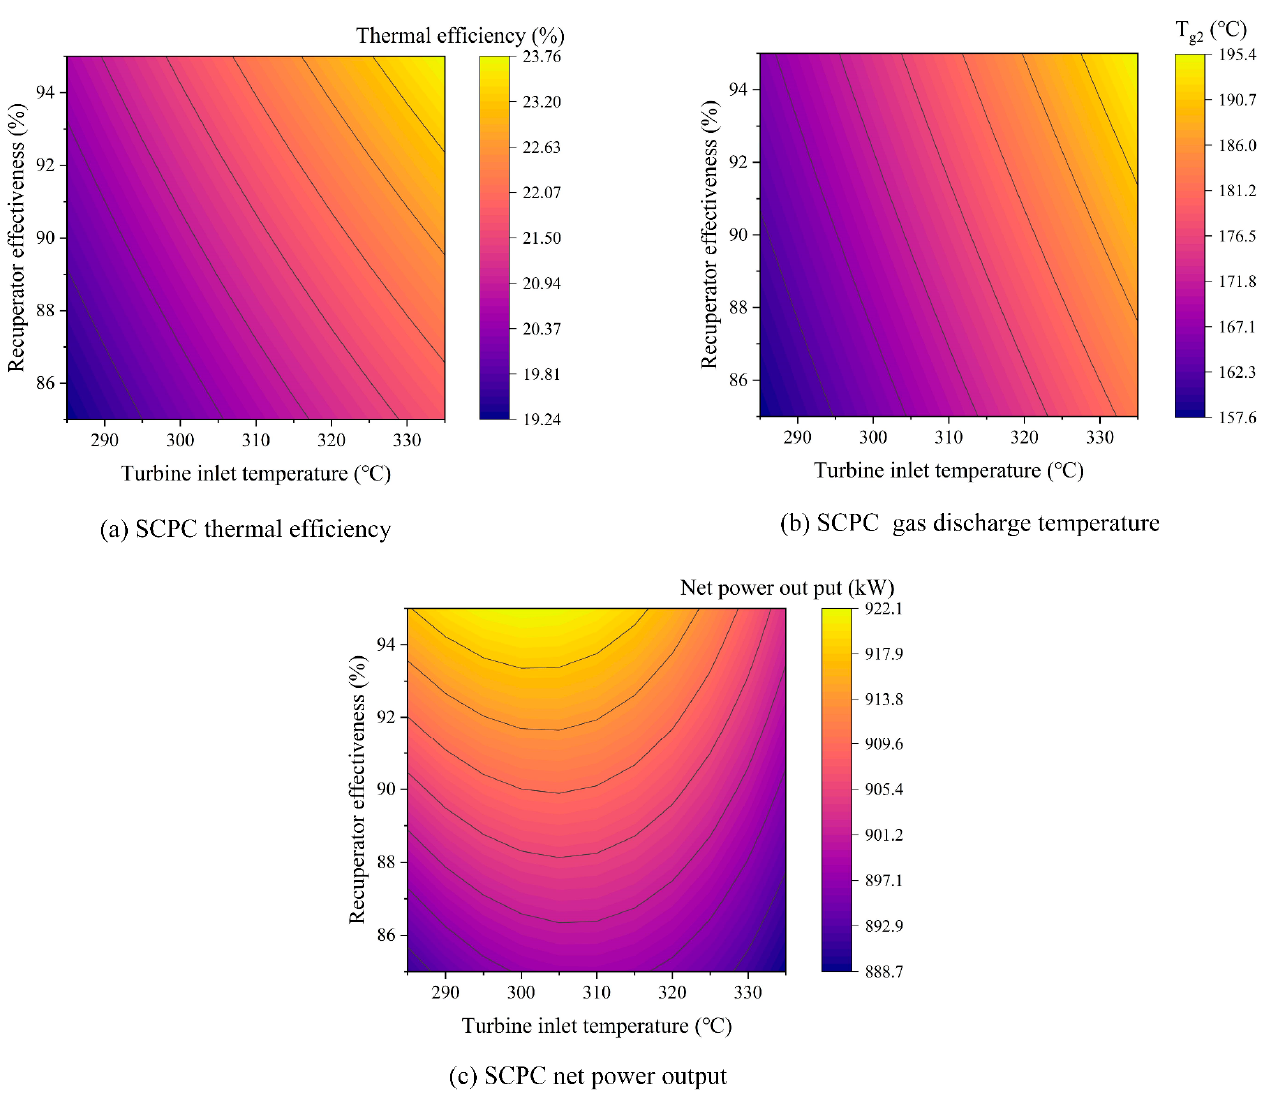
Figure 8. The effect of recuperator effectiveness and turbine inlet temperature on the performance of the SCPC: ( a ) thermal efficiency; ( b ) gas discharge temperature; ( c ) net power output.